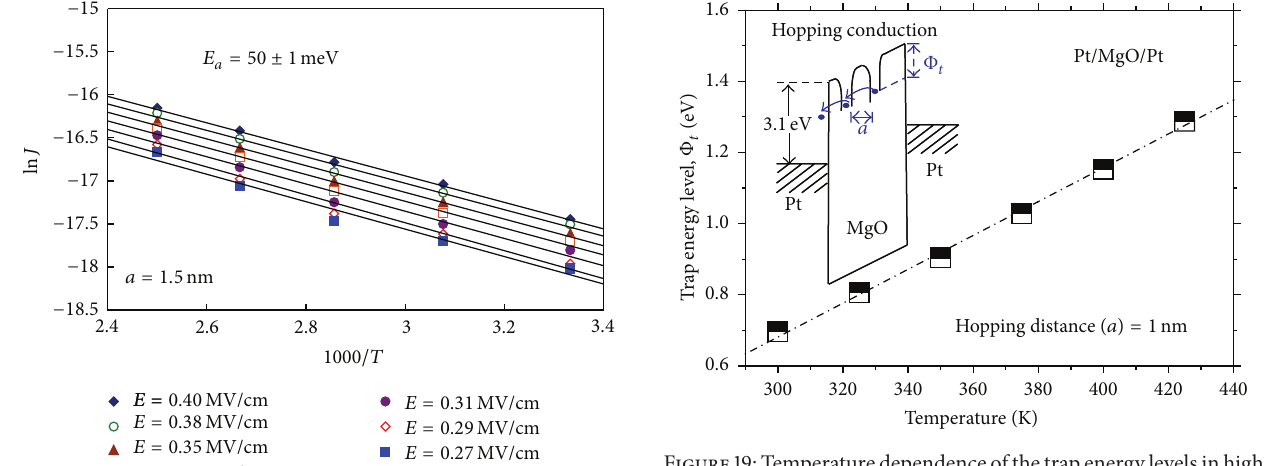
Figure19:Temperaturedependenceofthetrapenergylevelsinhigh resistance state. Inset graph shows the band diagram of hopping conduction in Pt/MgO/Pt memory cells.